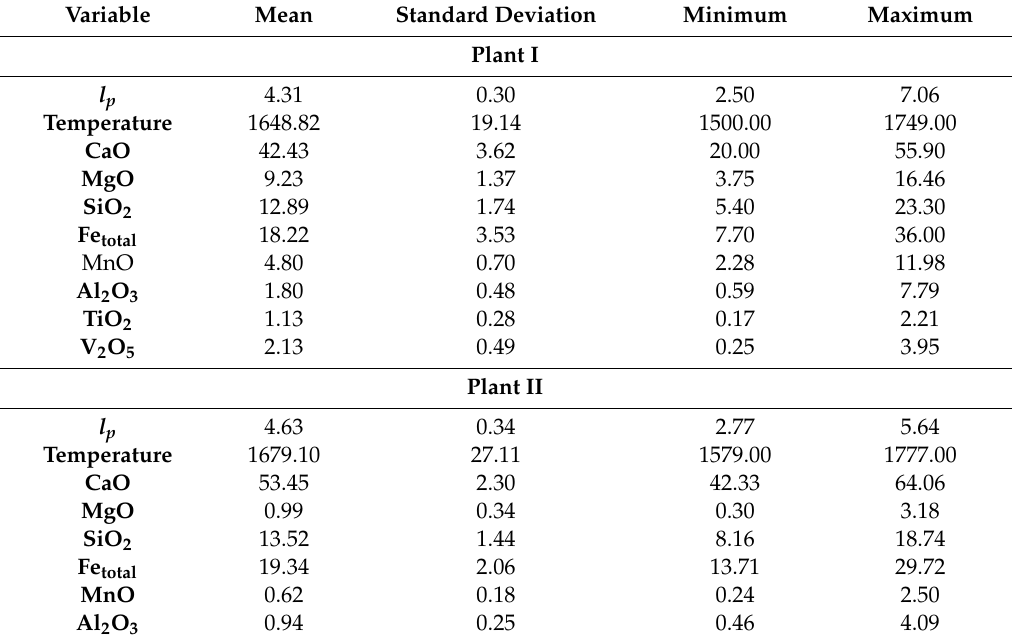
Table 1. Descriptive statistics of all features for plant I and plant II.